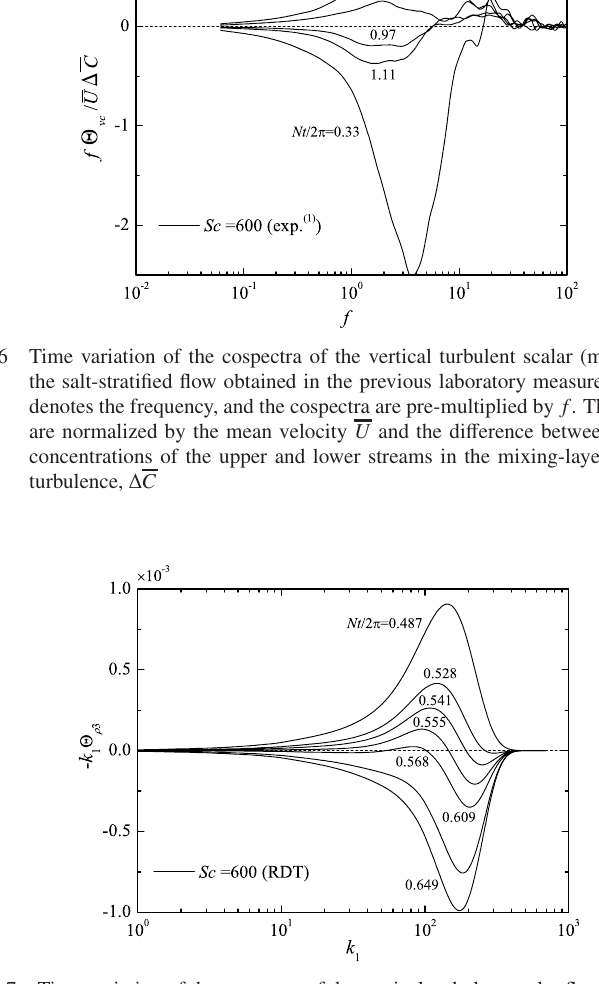
Fig. 7 Time variation of the cospectra of the vertical turbulent scalar flux in the salt- stratified liquid flow predicted by